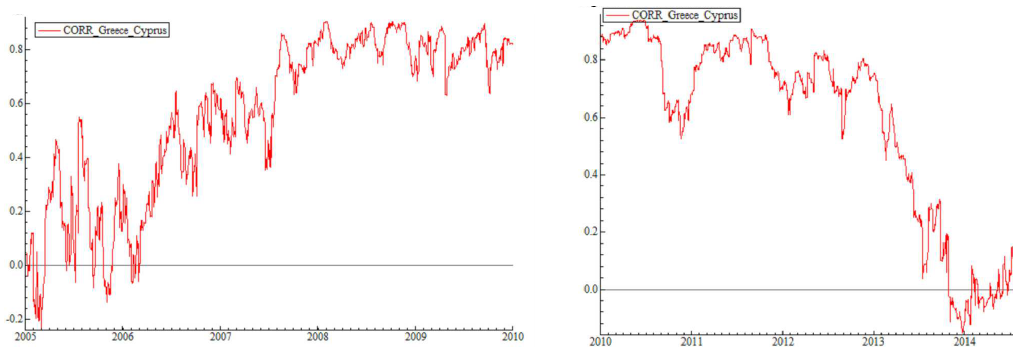
Figure 5. GFC covariance Figure 6. EDC covariance